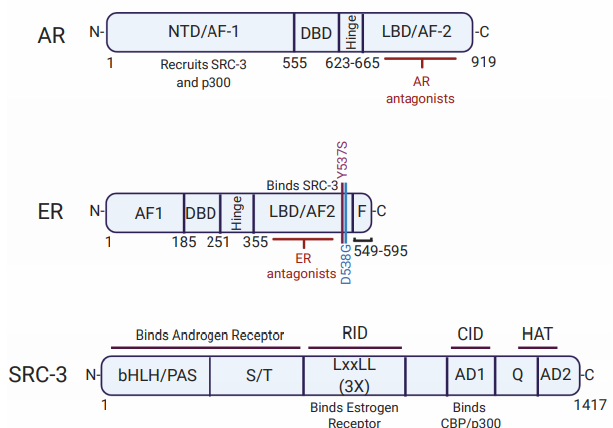
Figure 4. Structure of Androgen and Estrogen Receptors and their Co-activator SRC-3. The structural domains of AR, ER and SRC-3 are shown. The sites of their interactions are depicted. The ligand-binding domain of the AR and ER where antagonists bind is indicated. AD: activation domain; AF: activation function; bHLH/PAS: basic helix-loop-helix/per-arnt-sim domain; CID: CBP/p300 interaction domain; DBD: DNA-binding domain; F: F domain in the C-terminus of nuclear receptors; HAT: histone acetyltransferase domain; LBD: ligand-binding domain; NTD: N-terminal domain; RID: receptor interaction domain; Q: polyglutamate region; ST: serine/threonine rich region.